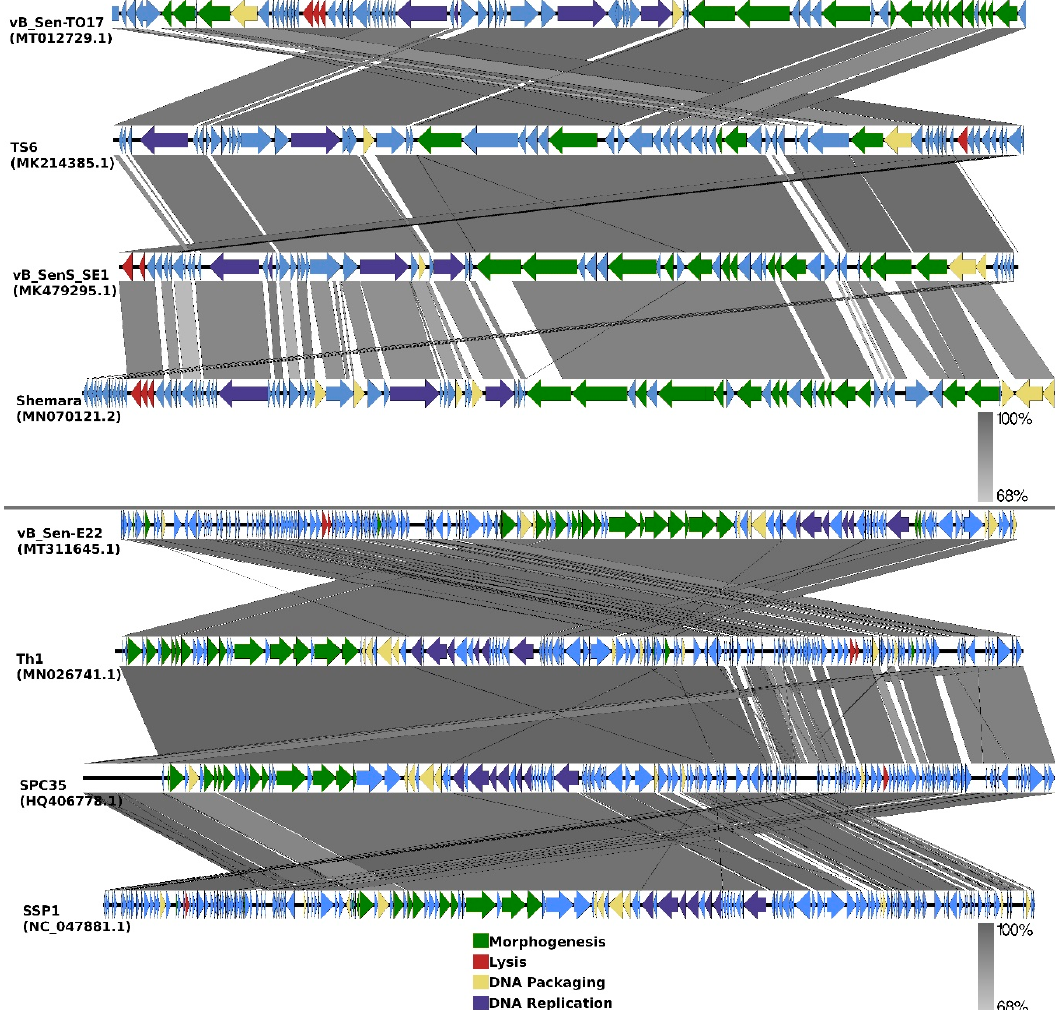
Figure 7. EasyFig output image of the genomic comparison between phages vB_Sen-TO17 and vB_Sen-E22, and the most closely related phages. Phage genomes are presented by linear visualization with coding regions shown as arrows. Selected open reading frames are colored in relation to their functions. The percentage of sequence similarity is indicated by the intensity of the gray color.